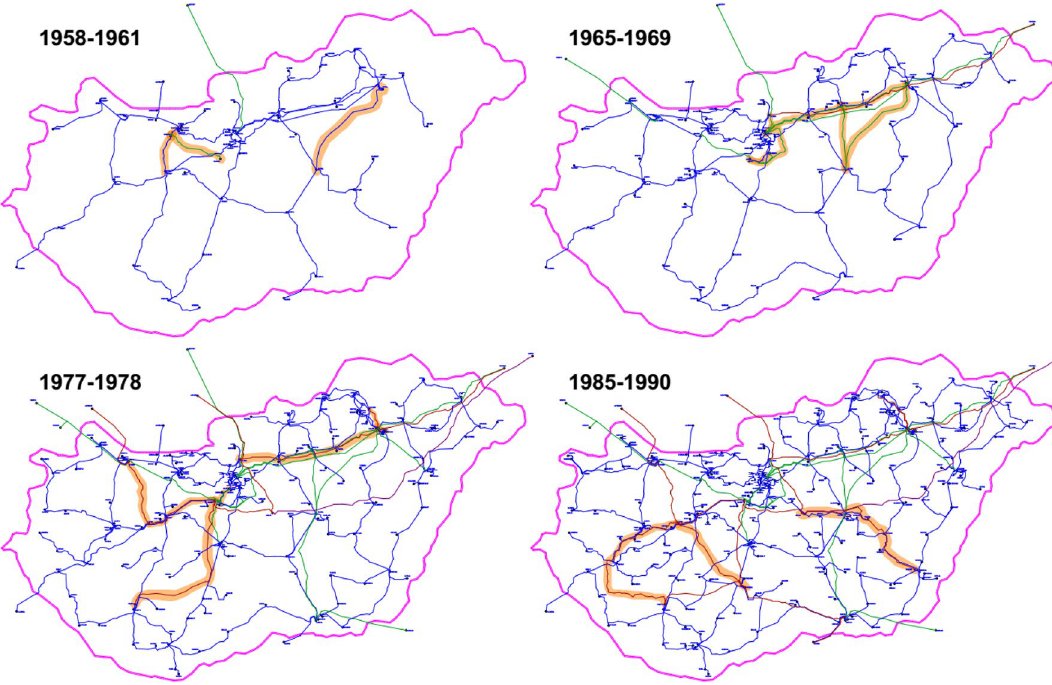
Figure 2. Four periods of network development activities, which have significantly increased the clustering coefficient of the network. A vast majority of the newly commissioned connections were 220 and 400 kV lines, creating a meshed topology with the underlying 120 kV network.